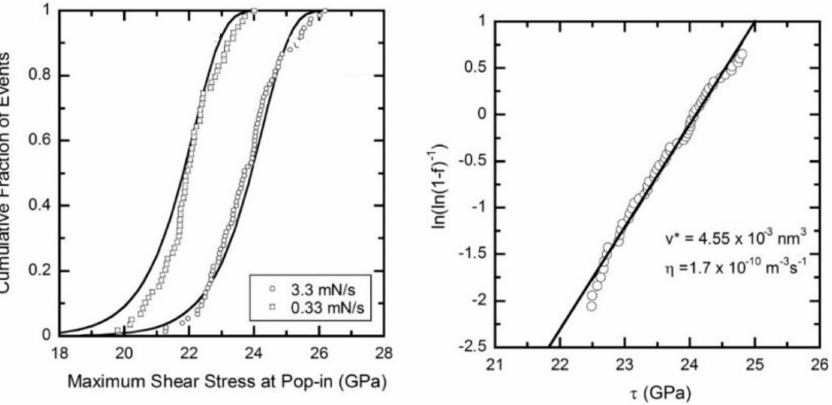
Figure 7. A cumulative proverbiality function and the estimated activation volume in TiC